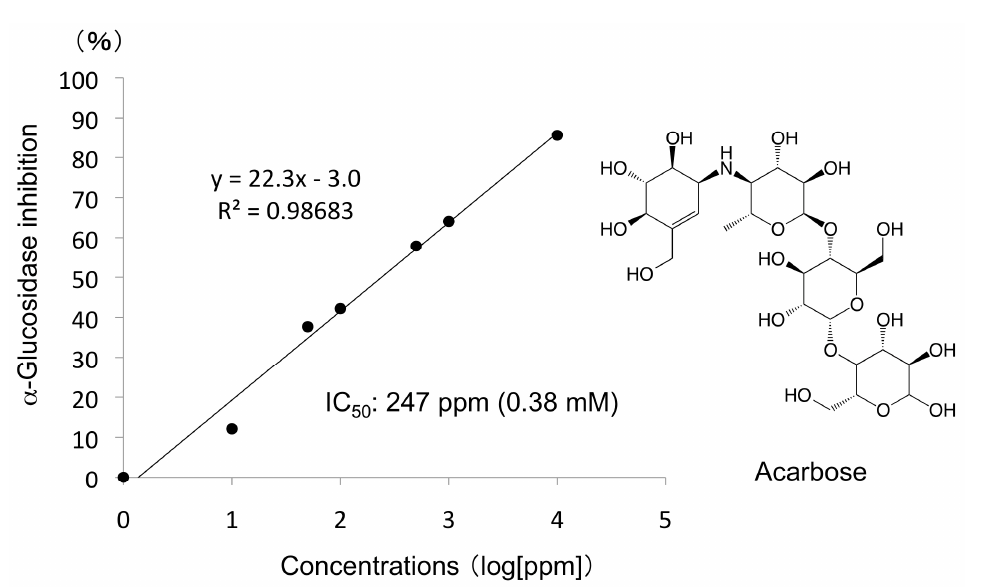
Figure 4. α -Glucosidase activity of acarbose against α -glucosidase from rat intestine acetone powder.